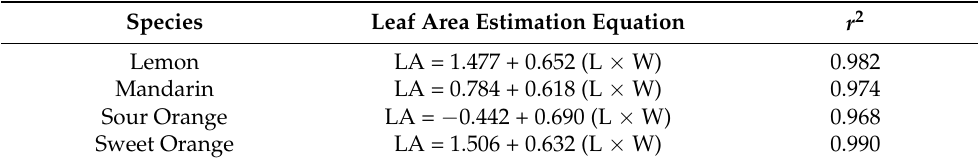
L = leaf maximum length, LA = leaf area and W = leaf maximum